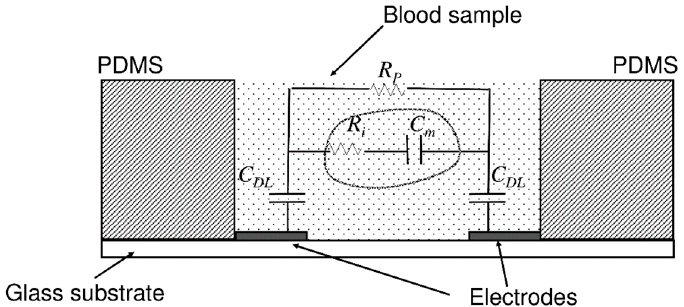
Figure 7. Electrical model representing three major blood components responsible for blood impedance, Rp – plasma resistance, Ri – Red blood cell interior resistance and Cm – Cell membrane capacitance. Taken with permission from [42].